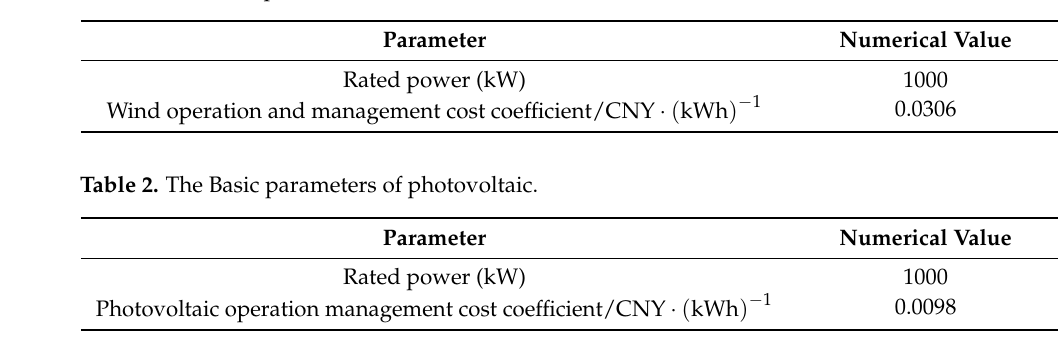
Table 1. The basic parameters of the fan.